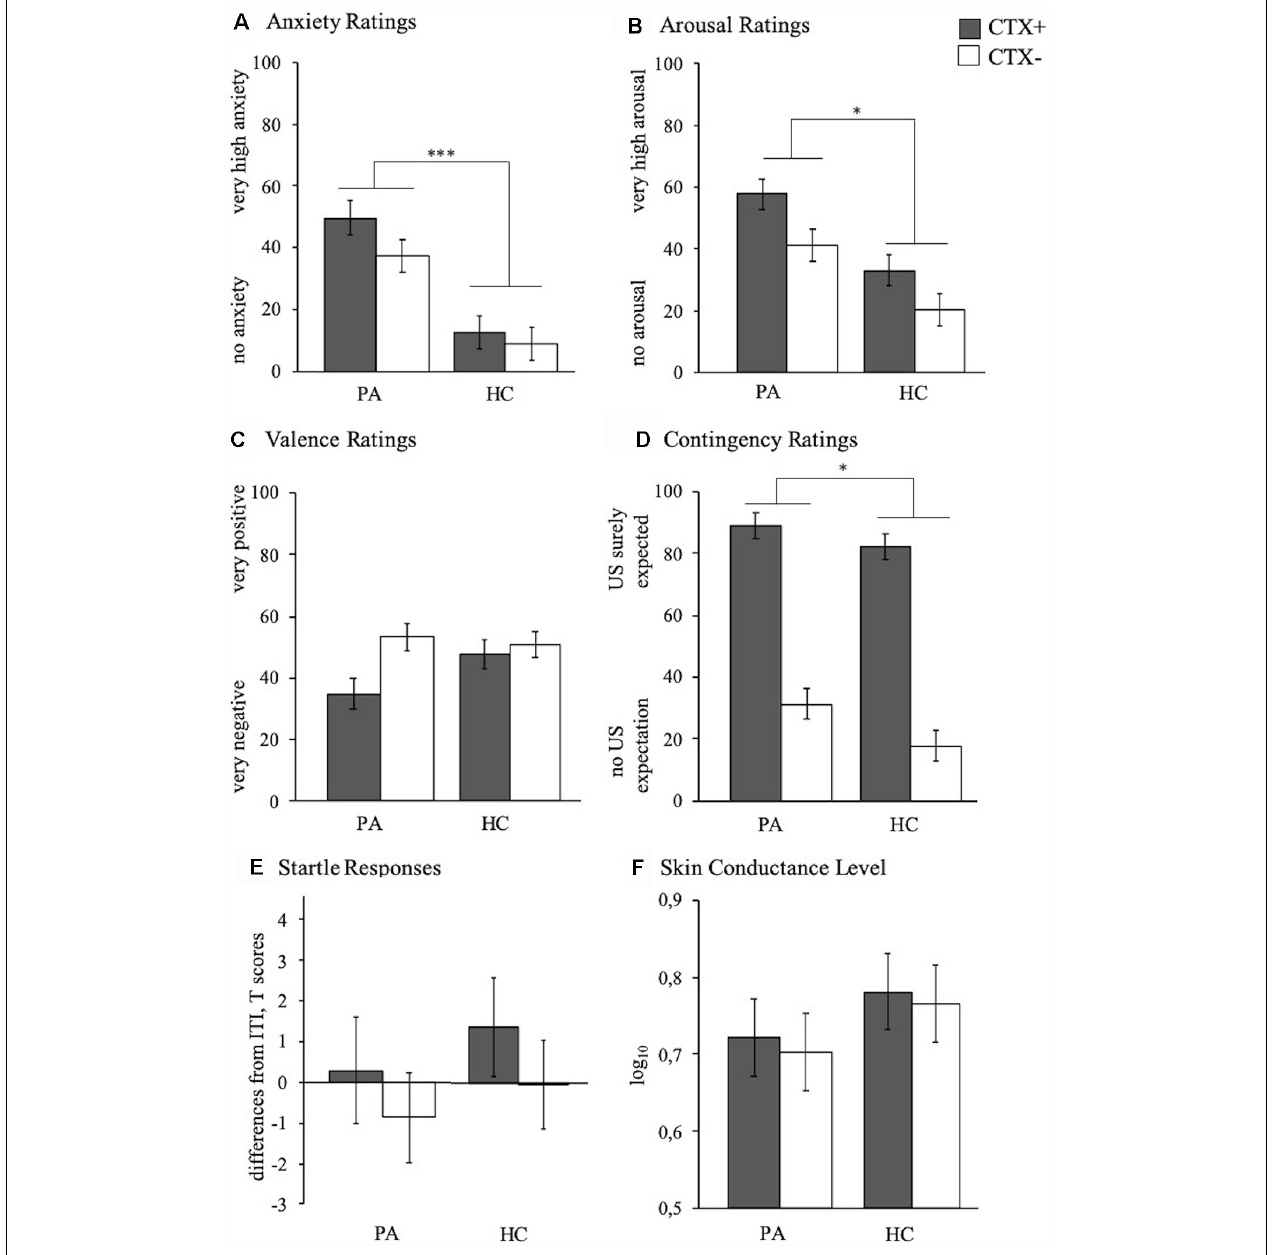
FIGURE 2 | Anxiety (A) , arousal (B) , valence (C) , and contingency (D) ratings as well as startle amplitude (E) and SCL (F) of participants with PA (left bars) and HC (right bars) to the CTX+ (gray) and the CTX − (white) during the acquisition phase. Depicted are mean responses (means and standard errors). ∗ p < 0.050, ∗∗∗ p <